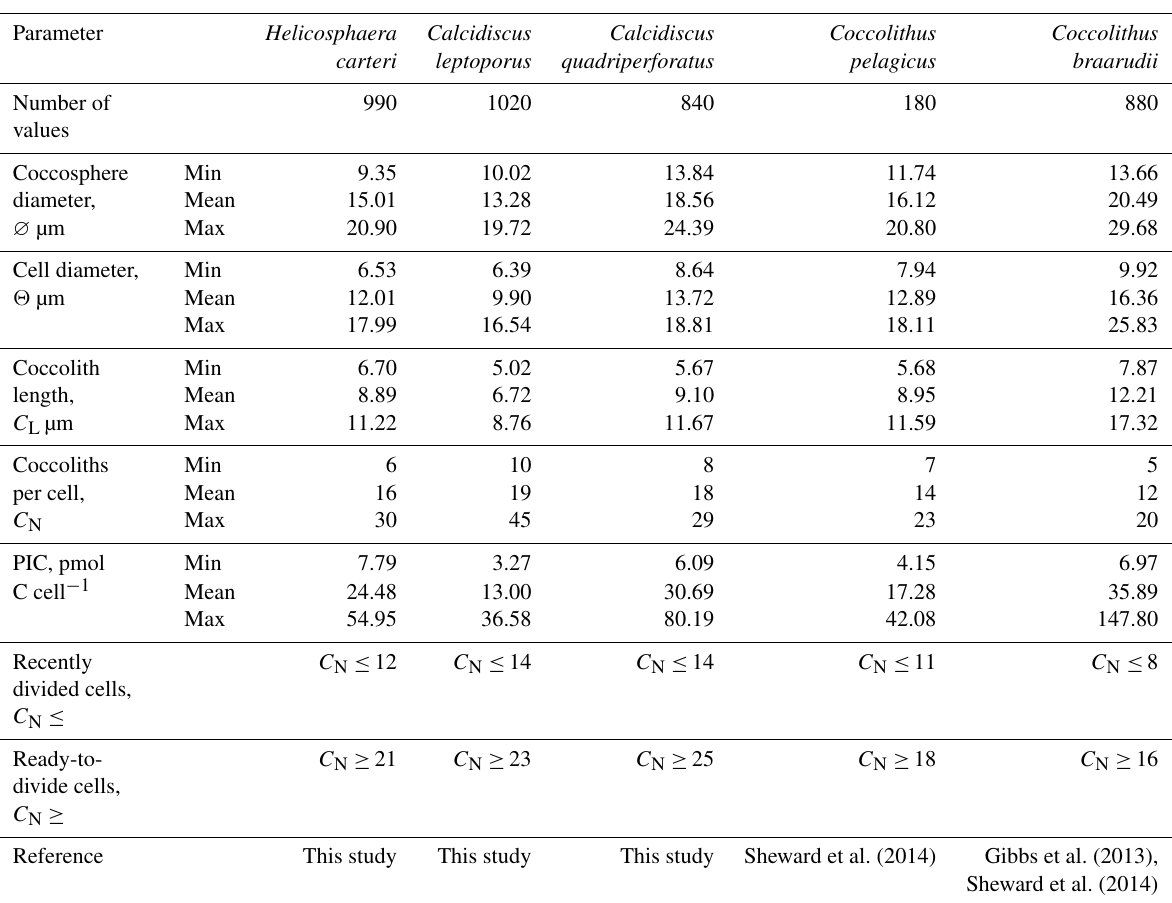
Table 1. Summary statistics of species-specific coccosphere geometry data, PIC (particulate inorganic carbon) and C N (number of coccoliths per cell) thresholds for classifying the proportion of recently divided and ready-to-divide cells in a population, based on the complete coccosphere geometry data set from all experiment days. Summary statistics for both growth phases are shown in Table S1. The full data set of experimental conditions, daily growth rates and coccosphere geometry measurements from each individual coccosphere is available as Sheward et al. (2016) at